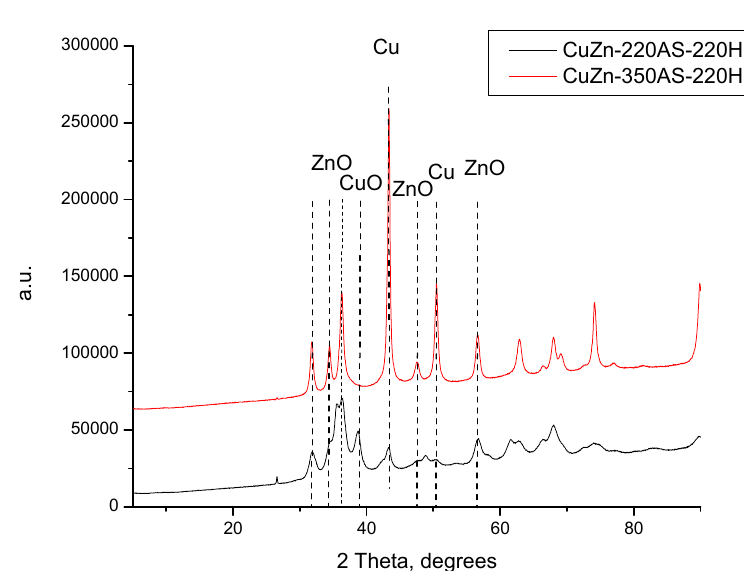
Figure A1. The XRD patterns of catalyst samples prepared by the treatment of the CuZn precursor in static air at 220 and 350 °C followed by the treatment in a hydrogen at T = 220 °C.